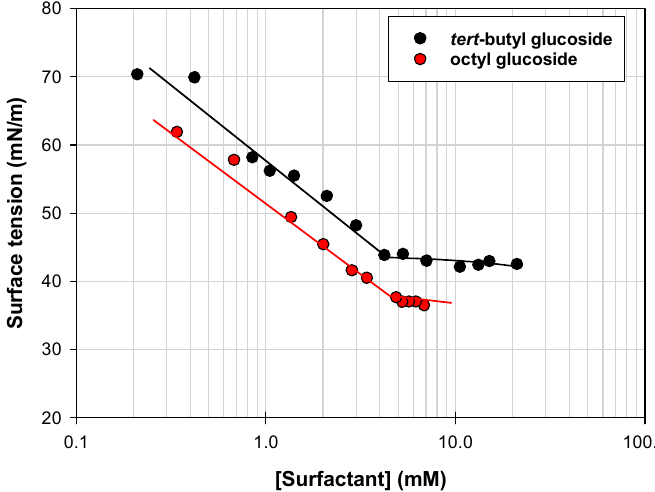
Figure 5. Variation of surface tension vs. concentration for tert -butyl and octyl